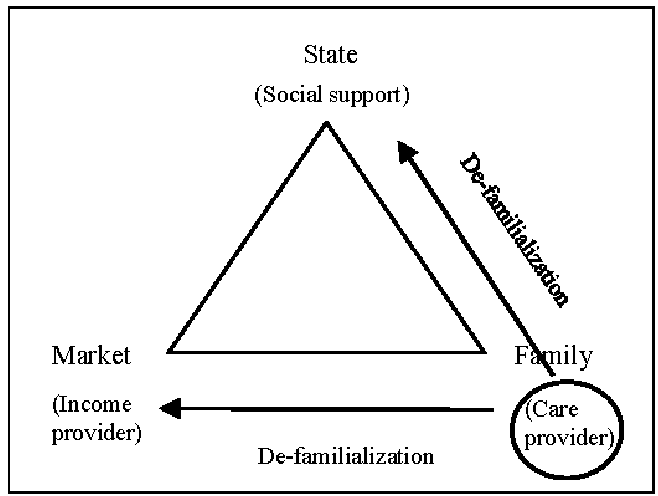
Figure 1. Distribution of welfare between market, family and the state.